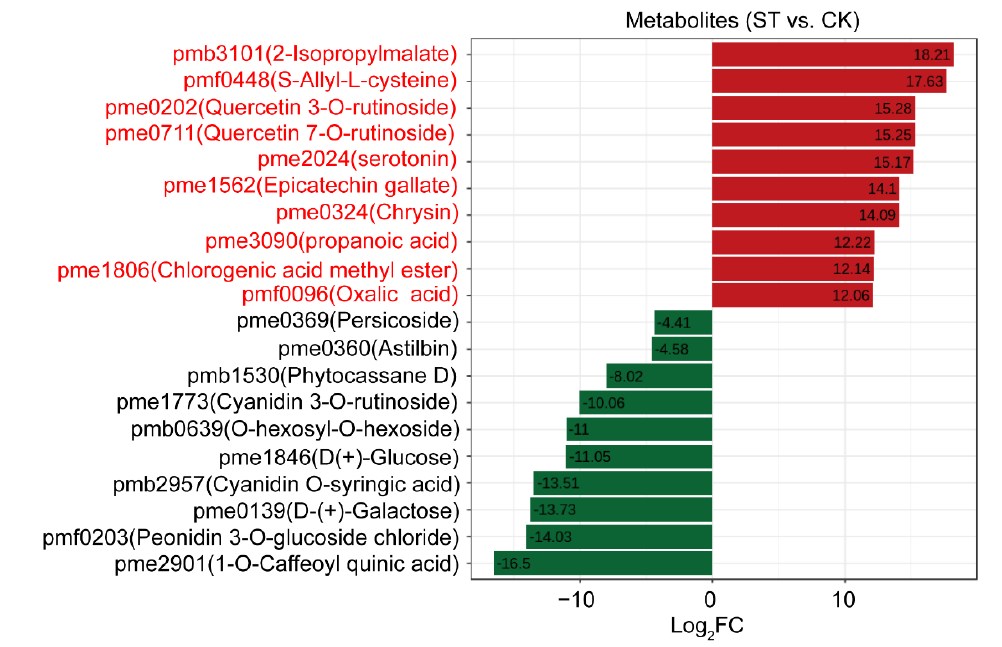
Figure 8. Heatmap representing the changes of metabolites related to anthocyanin metabolic pathway in response to low light treatments. The detailed abundance of metabolites was referred to in Table S8.